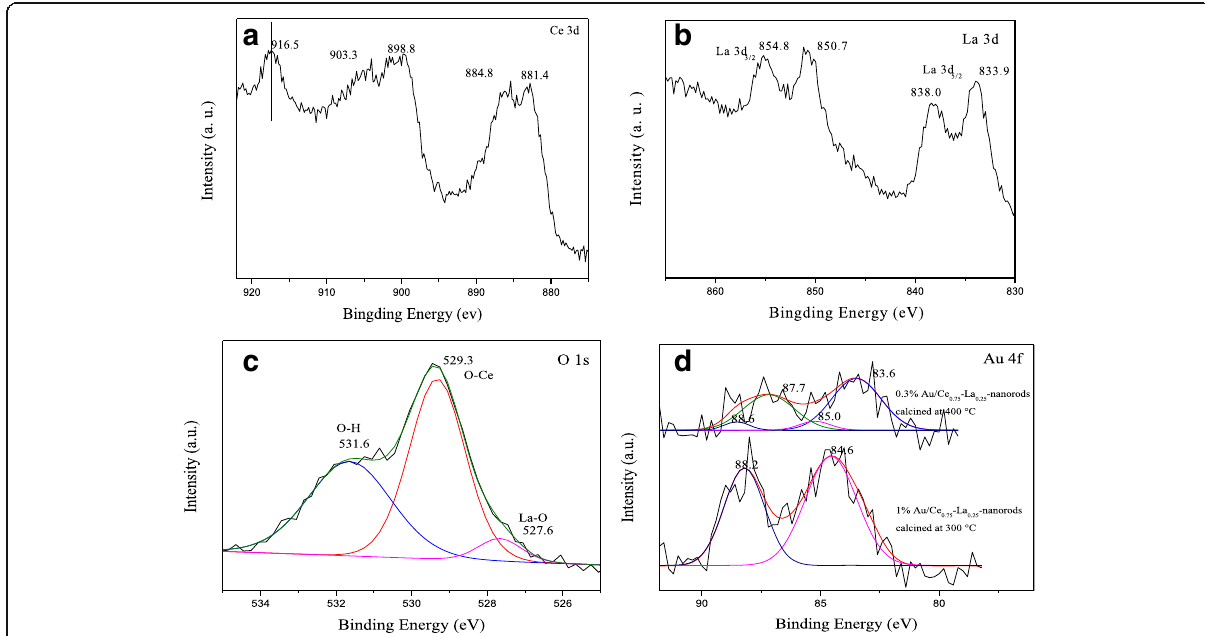
Fig. 6 XPS spectra of 1%Au/Ce 0.75 -La 0.25 nanorods calcined at 300 °C for 2 h: Ce 3 d peaks ( a ), La 3 d peaks ( b ), and O 1 s peaks ( c ). Au 4 f peaks ( d ) of Au/Ce 0.75 -La 0.25 nanorods calcined at 300 and 400 °C for 2 h